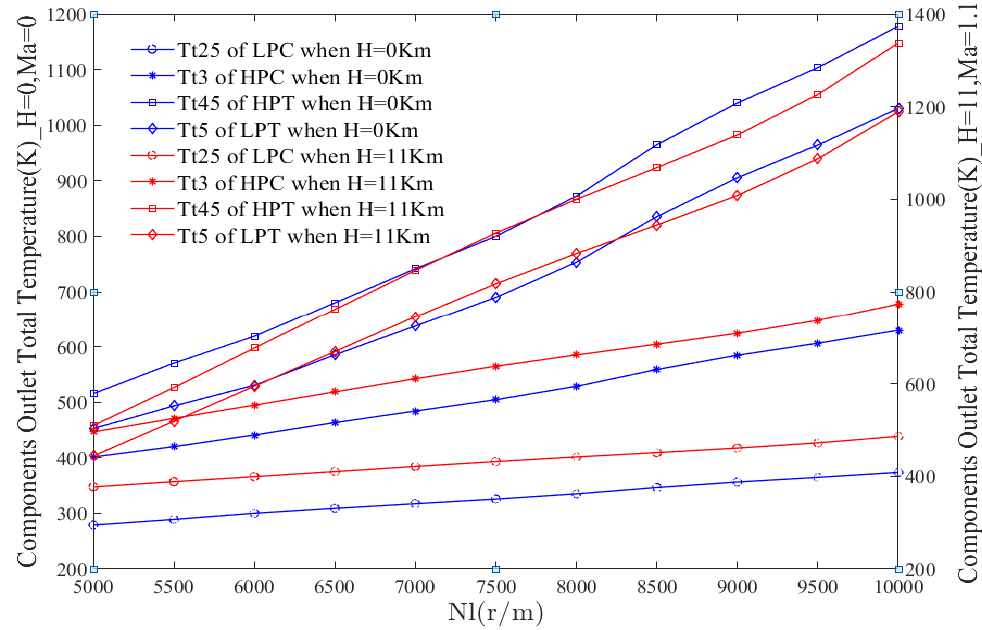
Figure 2. Total temperatures of components.